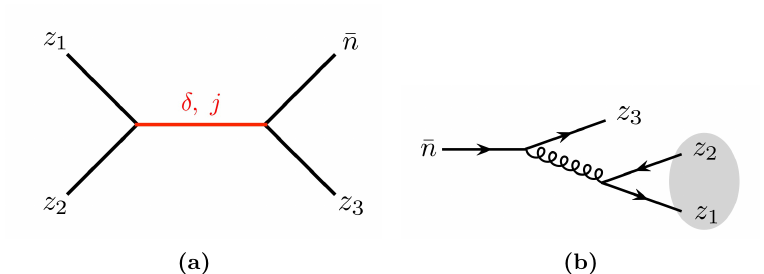
Figure 6. For the simple case of the q → q 0 ¯ q 0 q contribution to the three-point correlator, the OPE of the q 0 ¯ q 0 states isolates a perturbative gluon state with j = 0 , 2 . In this case the celestial block has the simple interpretation as kinematic power corrections to the leading splitting